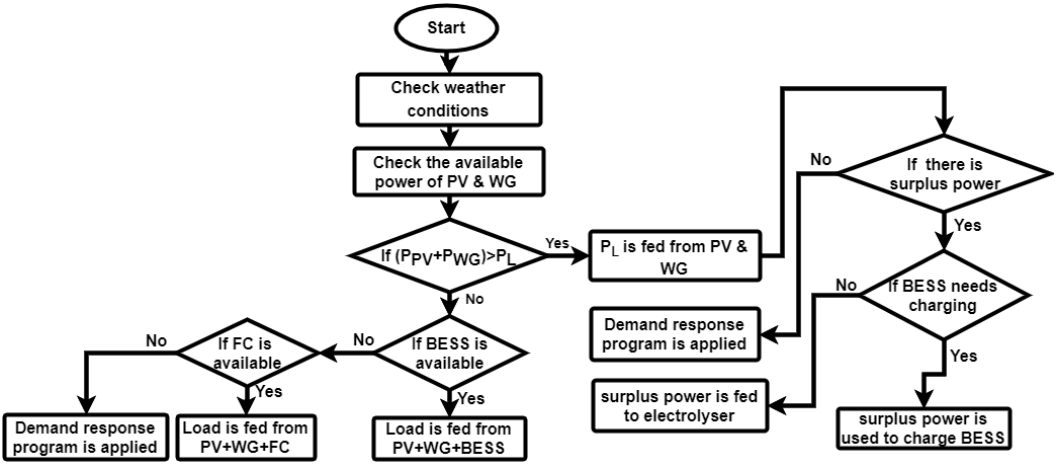
Figure 1. Proposed power system.